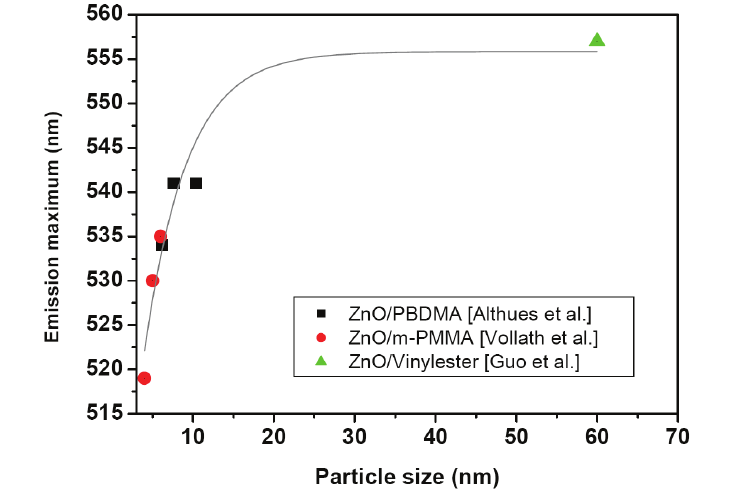
Figure 8. Particle size dependency of the emission maxima of ZnO/PBDMA nanocomposites (Data taken from Althues et al. [132]), ZnO/m-PMMA nanocomposite particles (Data taken from Vollath et al. [136]) and ZnO/Vinylester nanocomposites (Data taken from Guo et al.